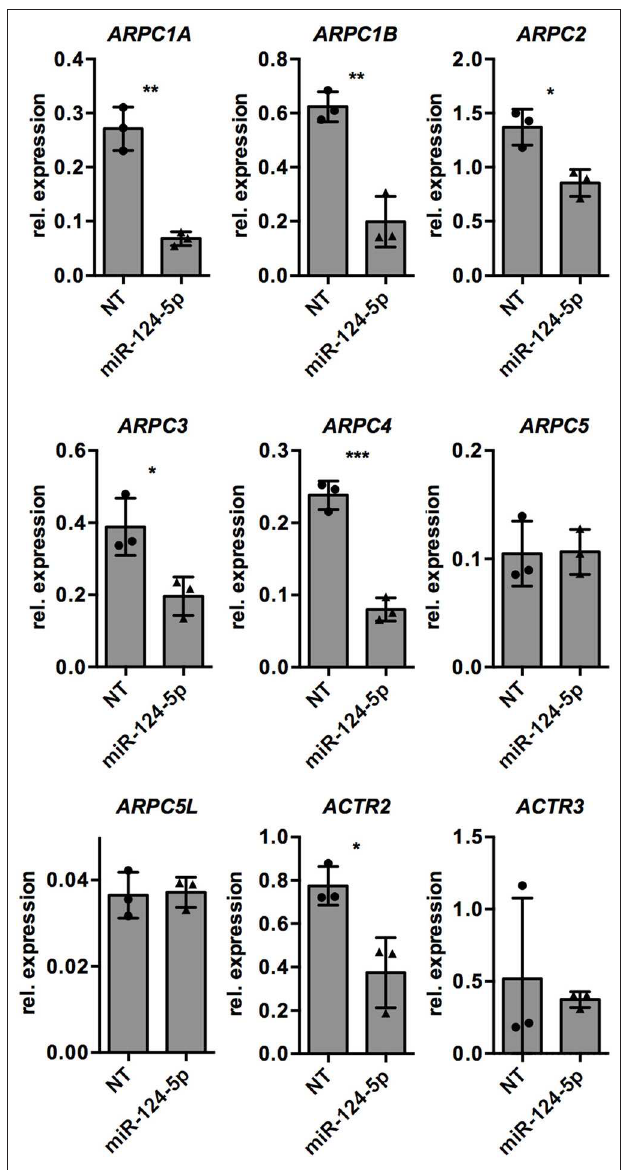
FIGURE 6 | Transfection with miR-124-5p alters expression of potential target genes in PMA-activated THP-1 M 8 . Expression levels of genes encoding the subunits of the ARP2/3 complex in PMA-activated THP-1 M 8 transfected with either the NT siRNA or miR-124-5p ( n = 3 independent experiments). Values from each experiment are indicated by symbols and the mean ± SD are indicated by a bar and whiskers. Statistical analysis was performed using Student’s t -test (* p < 0.05; ** p < 0.01; *** p <